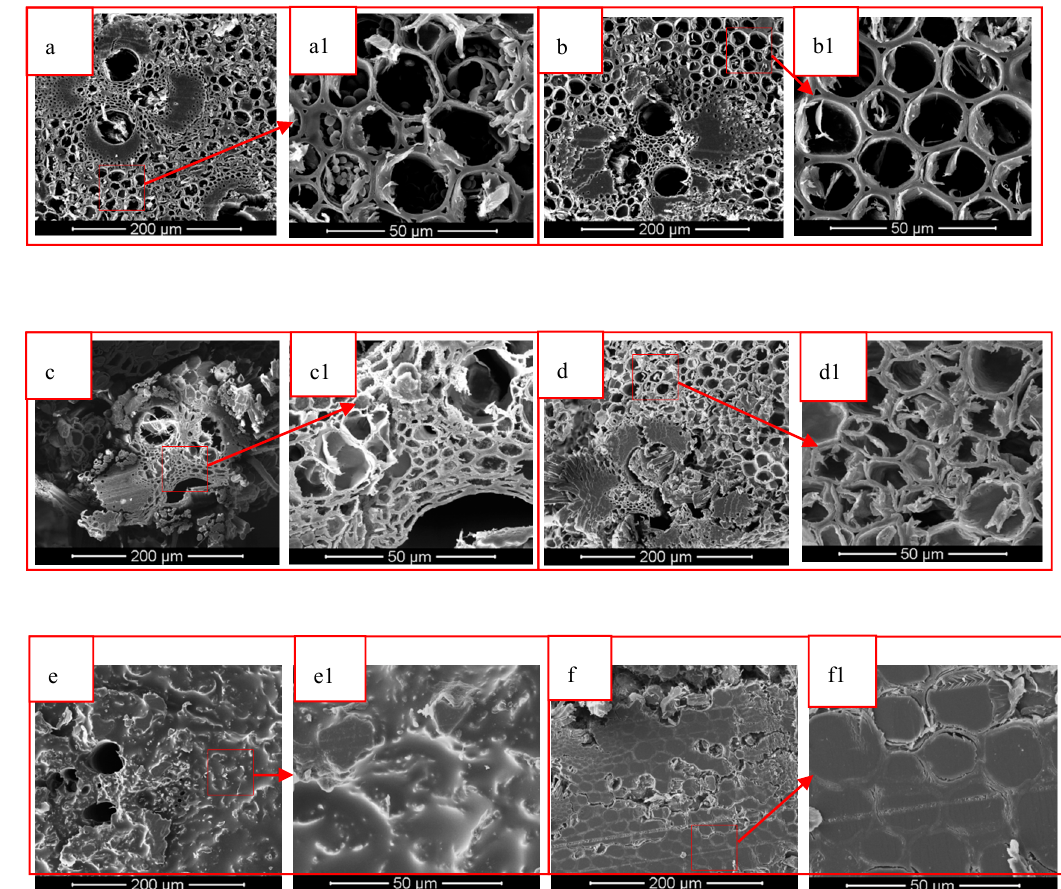
Figure 4. SEM images of IB and HIB before and after delignification and vacuum impregnation. (( a ) IB; ( b ) HIB; ( c ) DIB; ( d ) DHIB; ( e ) TIB; ( f ) THIB; ( a1 – f1 ) are the enlarged images)).